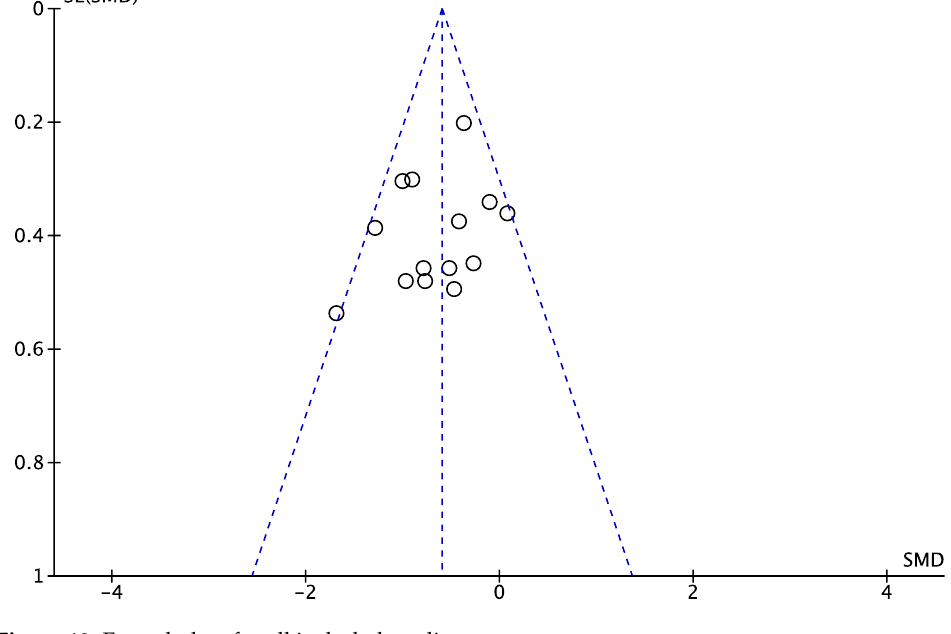
Figure 10. Funnel plots for all included